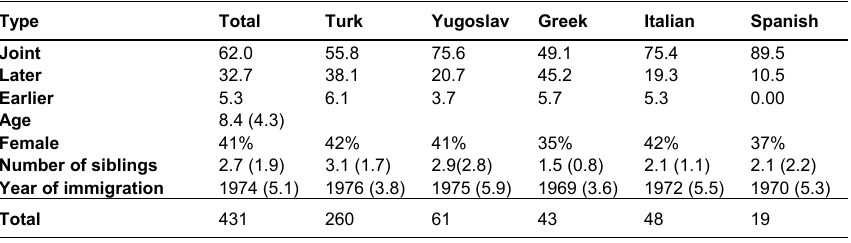
Table 2. Type of child’s migration (earlier, joint, later than